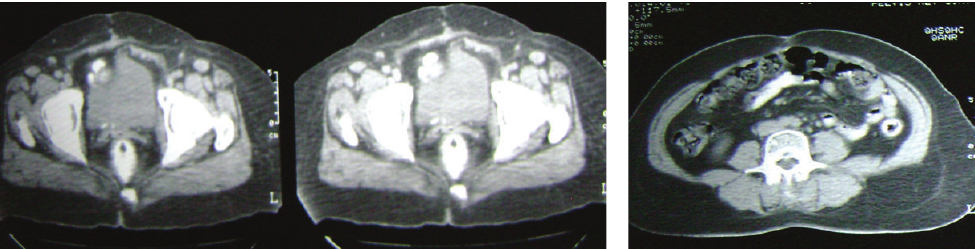
Figure 4: CT scan after 24 weeks following 6